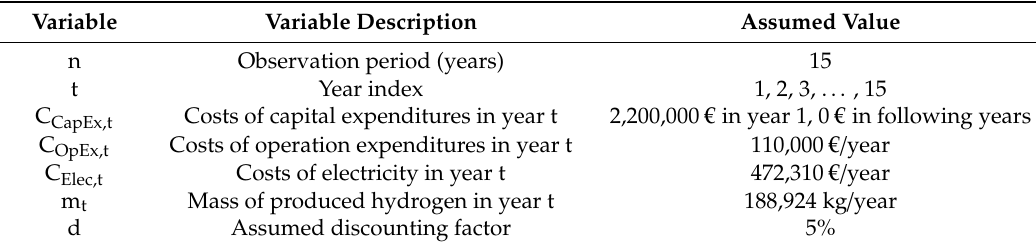
Table 7. Descriptions of the variables and their assumed